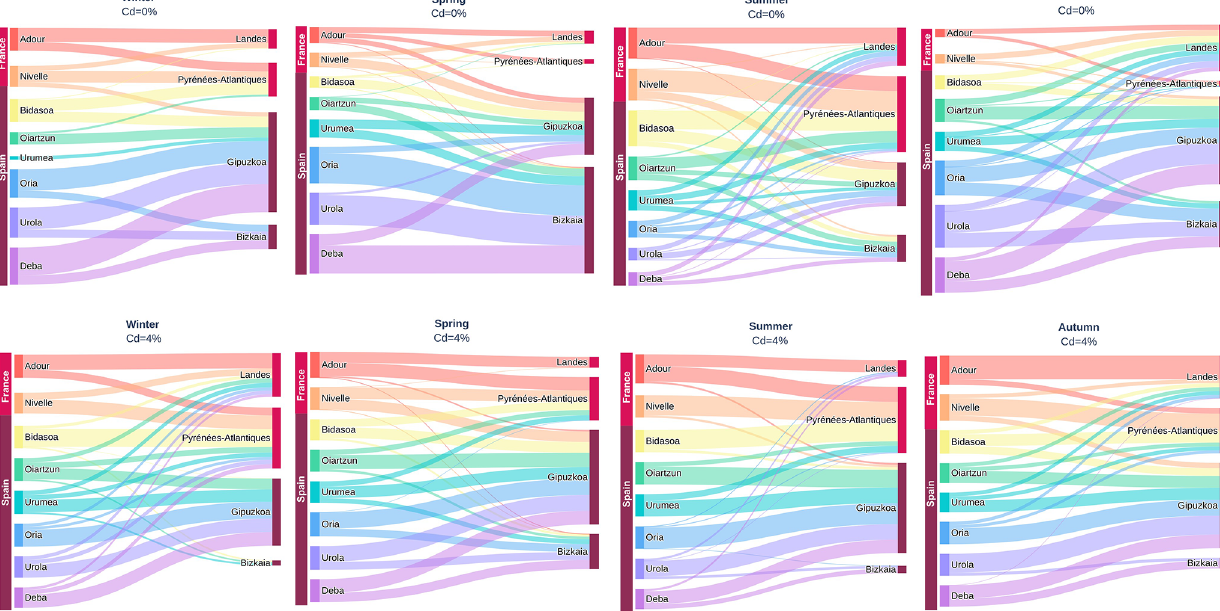
Figure 10. Seasonal analysis of the beached particles parameterized with C d = 0% and C d = 4% per region and river by the end of the simulation period. The nodes of the region correspond to the number of beached particles. The country to which each river belongs – France (Pyrénées-Atlantiques) and Spain (Gipuzkoa) – is shown on the left side of each figure. The width of the node depicts the sum of the beached particles, and the links represent the number of particles beached per